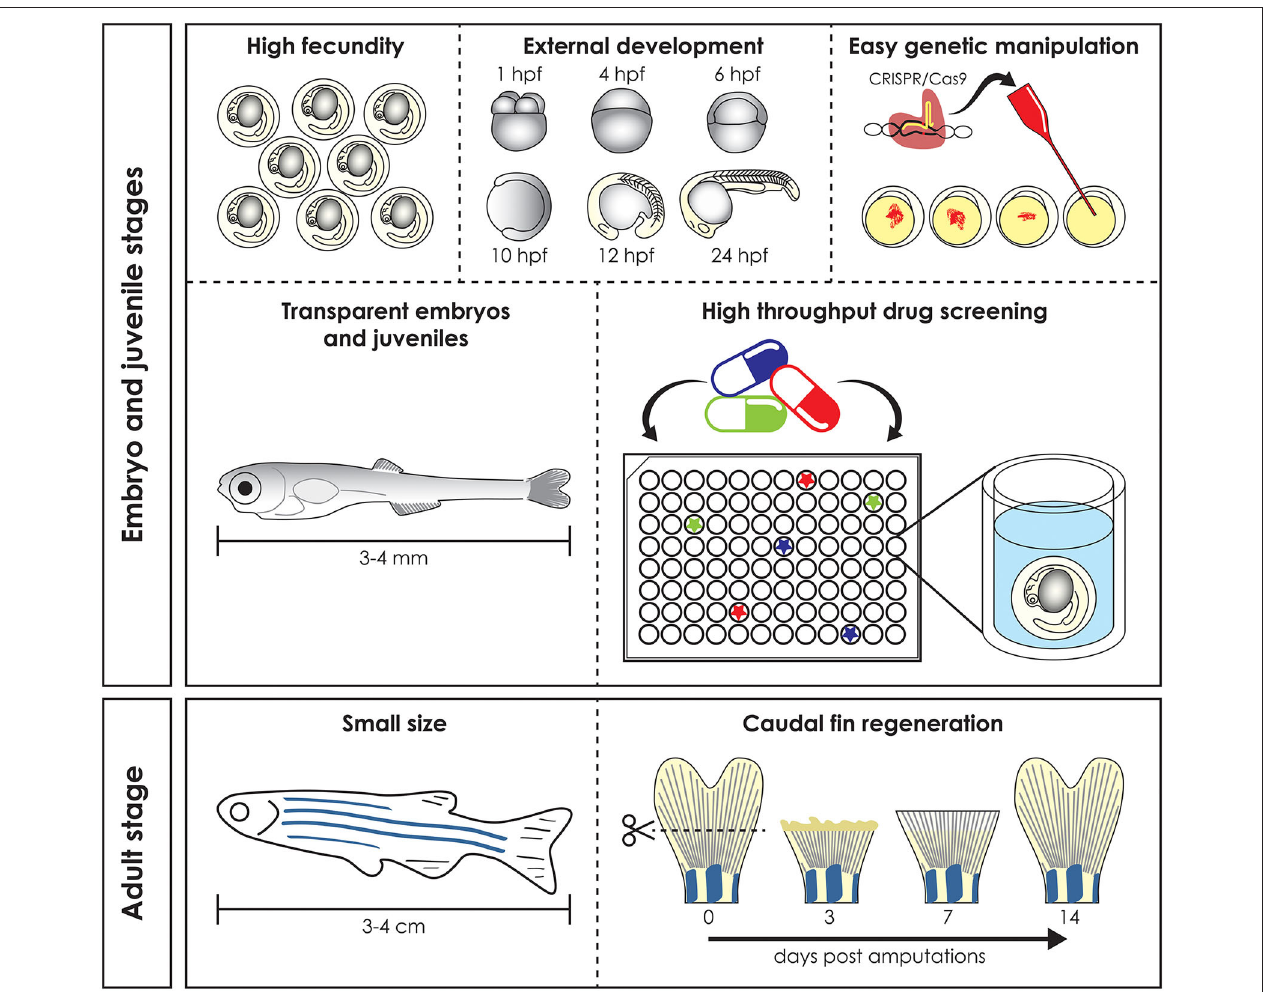
FIGURE 1 | Advantages of the zebrafish model. Zebrafish has several advantages compared to mammal models. High fecundity and external fertilization and development allow easy genomic manipulation, transparent early life stages guarantee in vivo imaging and skin permeability makes them suitable for high throughput drug screening (top). Adult zebrafish reaches a maximum size of 3–4cm and this make it easy and cheap to keep it in large numbers, reducing the husbandry cost (bottom left). Finally, zebrafish is used as a vertebrate model to study regeneration, due to its ability to regenerate different organs, such as the caudal fin, which is completely regenerated 14 days post amputation (bottom right). hpf, hours post